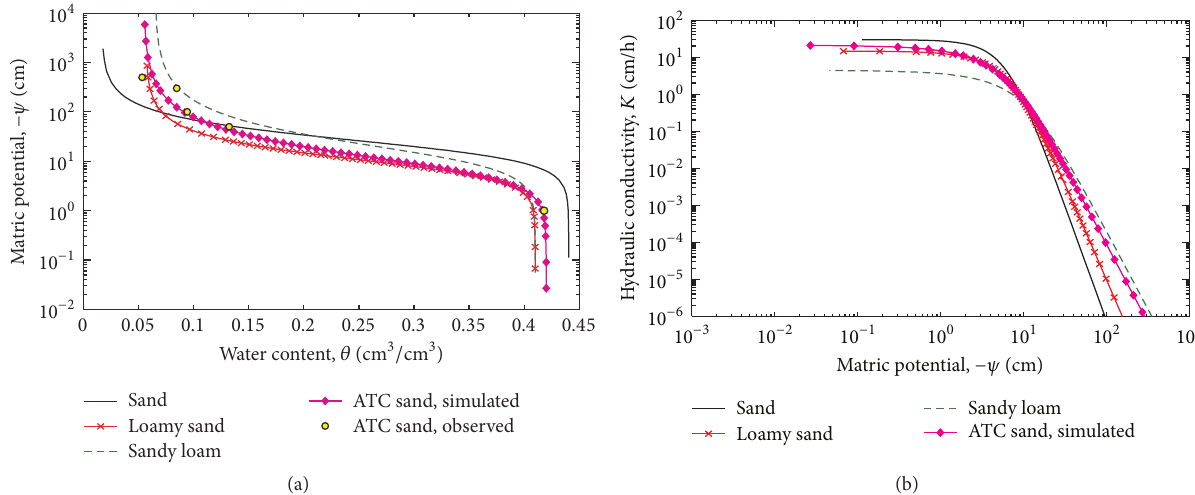
Figure 5: (a) Plot of water retention function for different unsaturated porous media using the soil parameters presented in Table 1, according to the formulation of van Genuchten [17] and (b) unsaturated hydraulic conductivity as a function of matric potential by using soil hydraulic parameters included in Table 1 and (5).